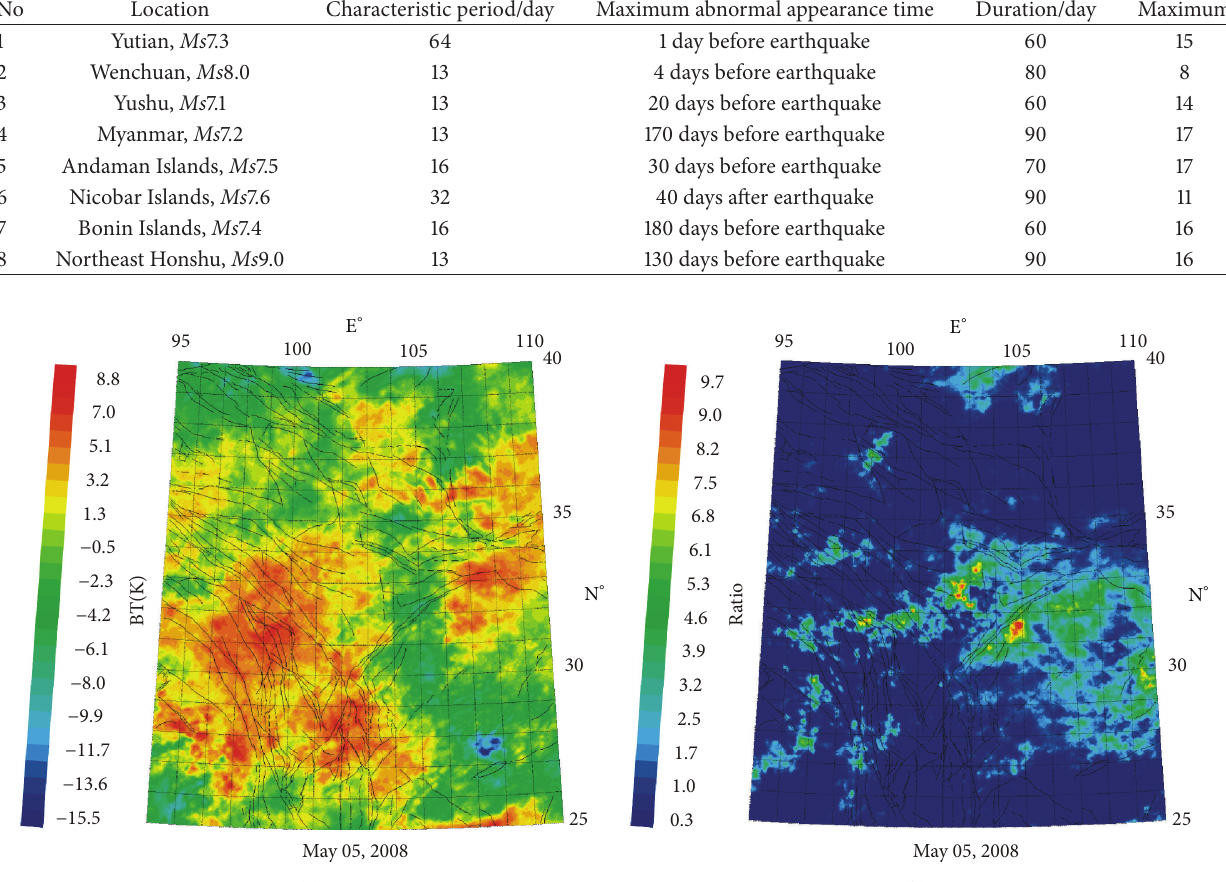
Table 2: The results of characteristics analysis.